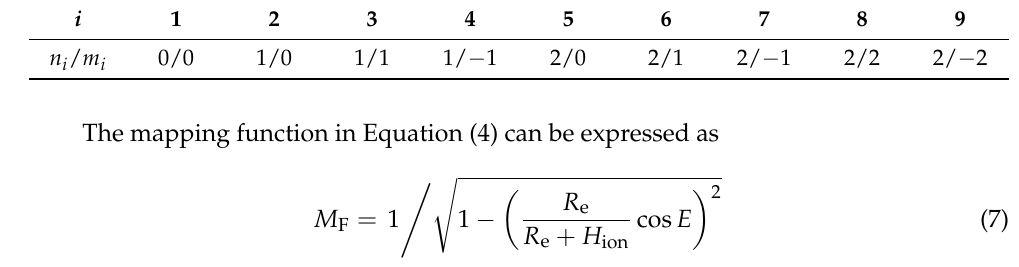
In Equations (5) and (6), ϕ (cid:48) and λ (cid:48) are the geomagnetic latitude and longitude of ionospheric pierce point (IPP) in the solar-fixed reference frame. a k , j and b k , j are the non- broadcast coefficients of BDGIM, and T k are the corresponding periods for prediction. t p is the odd hour of the modified Julian day. P | are the un-normalized Legendre functions n i | , | m i | with degree | n i | and order | m i | , and N n are the normalization functions. According to i , m i the ICDs, the values of n i and m i are listed in Table 1 [15,16]. Table 1. The values of n i and m i . Table 1. The values of 𝑛 (cid:3036) and 𝑚 (cid:3036) .